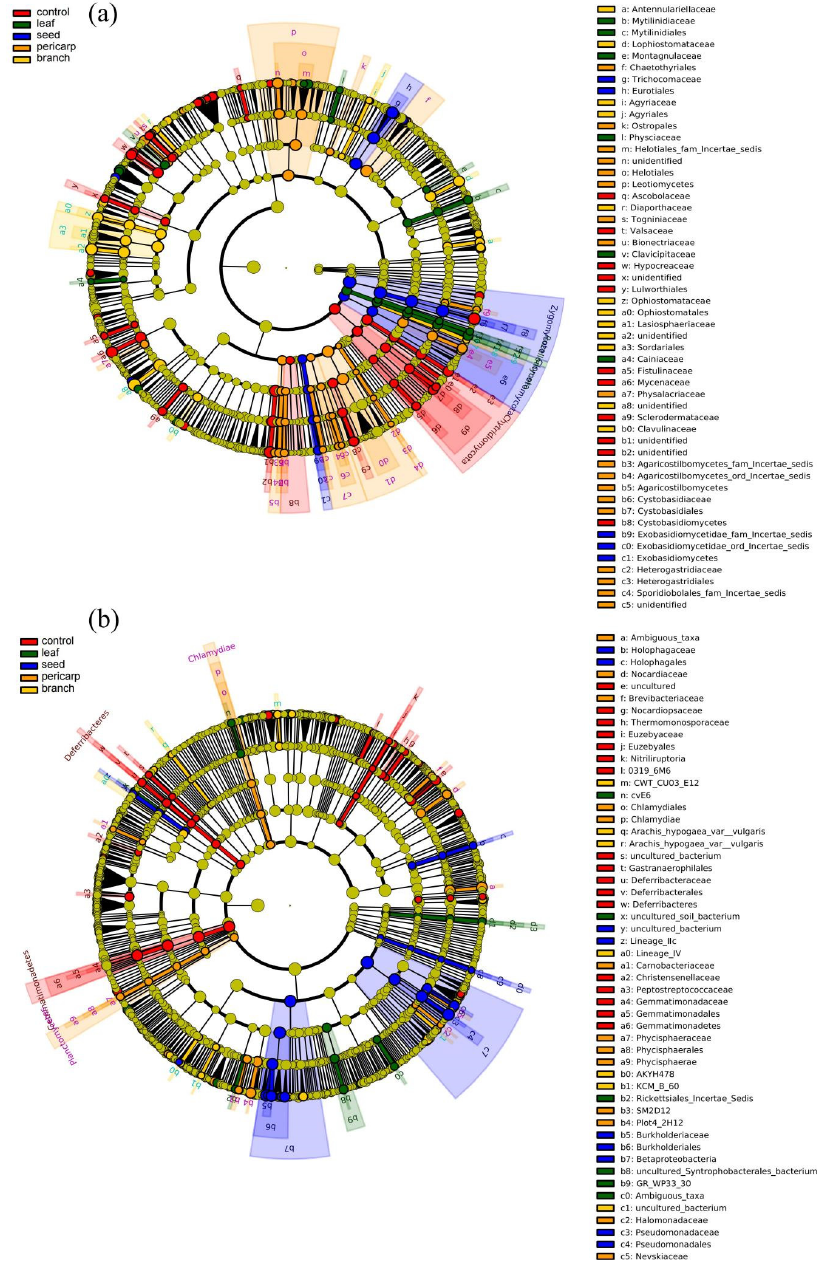
Figure 5. Linear discriminant analysis (LDA) coupled with effect size measurements. ( a ) Fungi, ( b ) bacteria. The circle radiating from inside to outside represents the taxonomic level from phylum to genus (or species). Each small circle at different classification levels represents a classification at that level, and the diameter of the small circle is directly proportional to the relative abundance. The species with no significant difference are uniformly colored yellow, and the different species biomarkers follow the group. The microbial groups that play an important role are in different color groups. The green node represents the microbial groups that play an important role in the green group, and the color meaning of other circles is similar. The species names represented by lowercase letters in the figure are shown in the legend on the right.